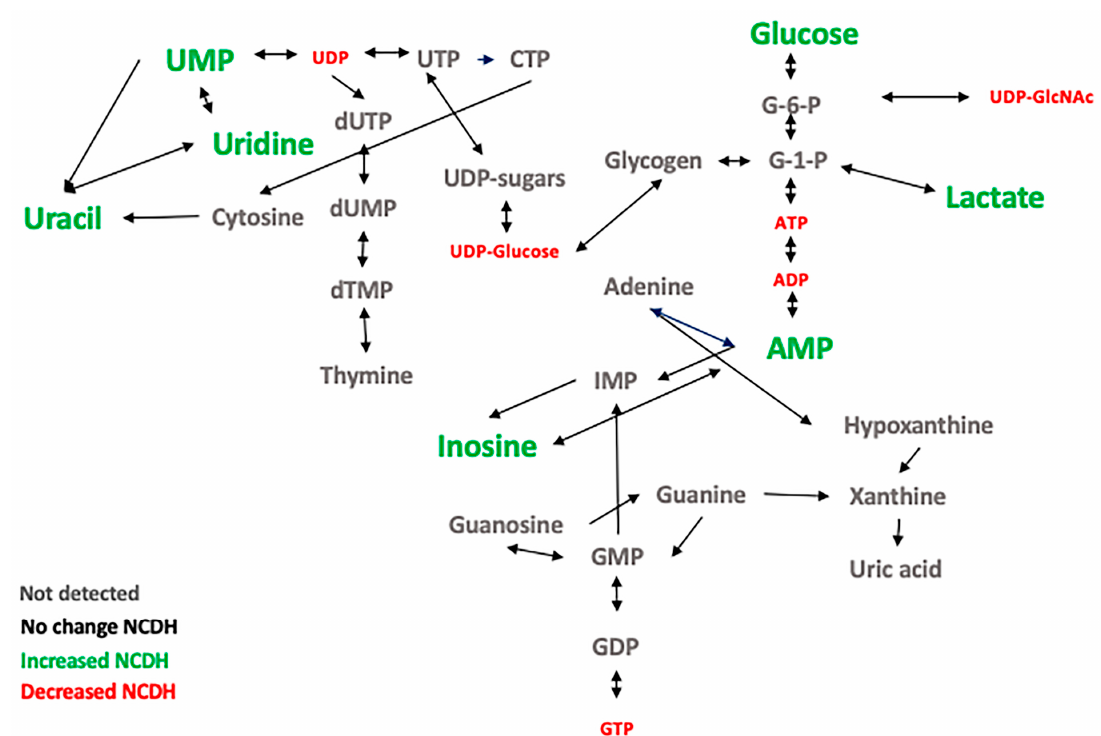
Figure 6. Alterations of nucleotide metabolism in fetal CDH lung. The overview of the metabolic flow of nucleotide metabolites and changes identified in the NCDH group compared with the VC group. Green (increased), red (decreased), black (no change), and grey